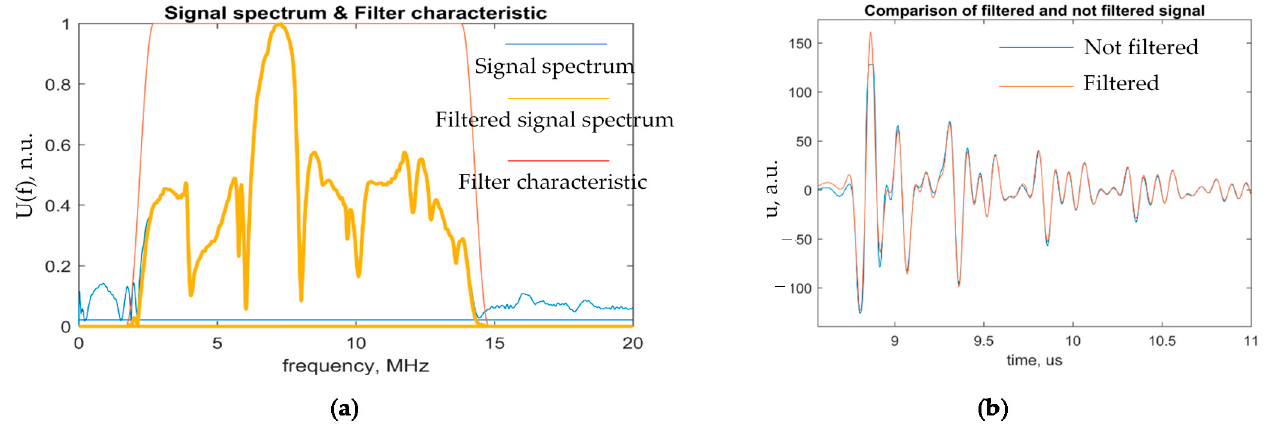
Figure 9. Signal filtering: ( a ) Signal spectrum and filter characteristics; ( b ) Comparison of filtered and not filtered signals.